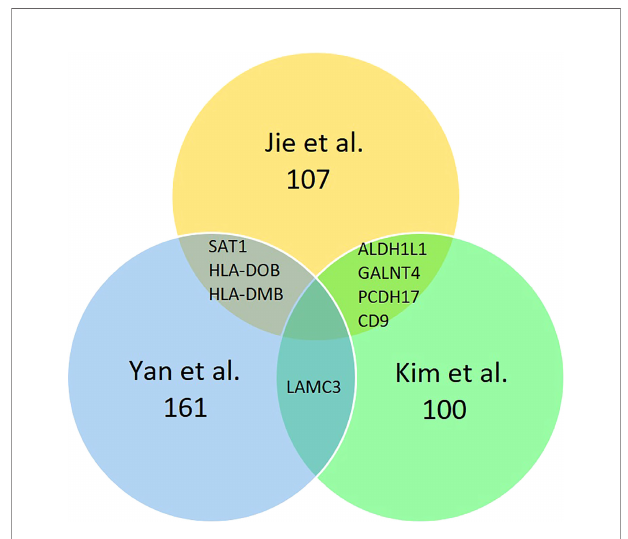
FIGURE 2 | Identi fi cation of 368 DEGs from the three cohort datasets. Different color areas represent other datasets. The overlapping areas are the common differentially expressed genes.